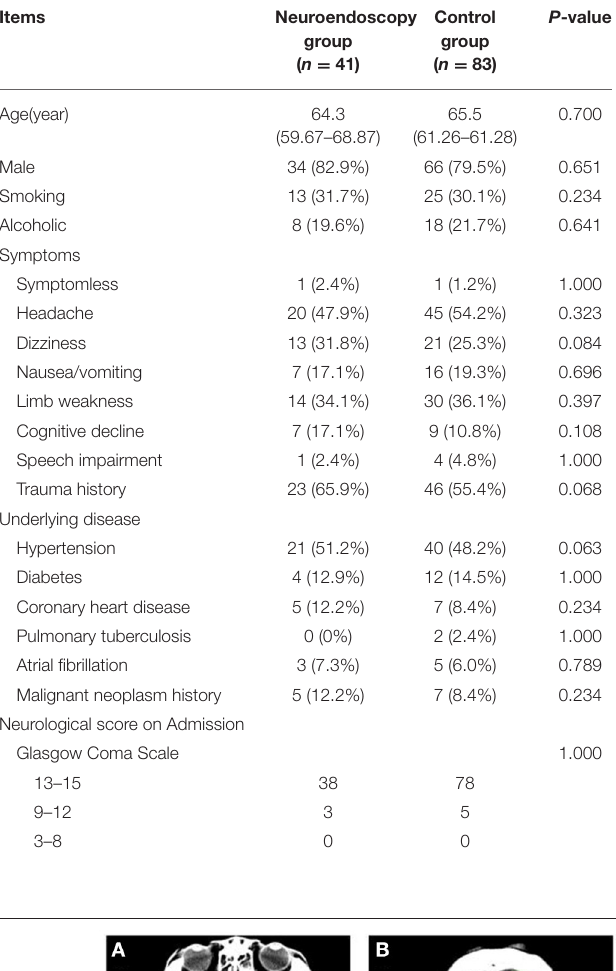
TABLE 1 | Baseline characteristics.